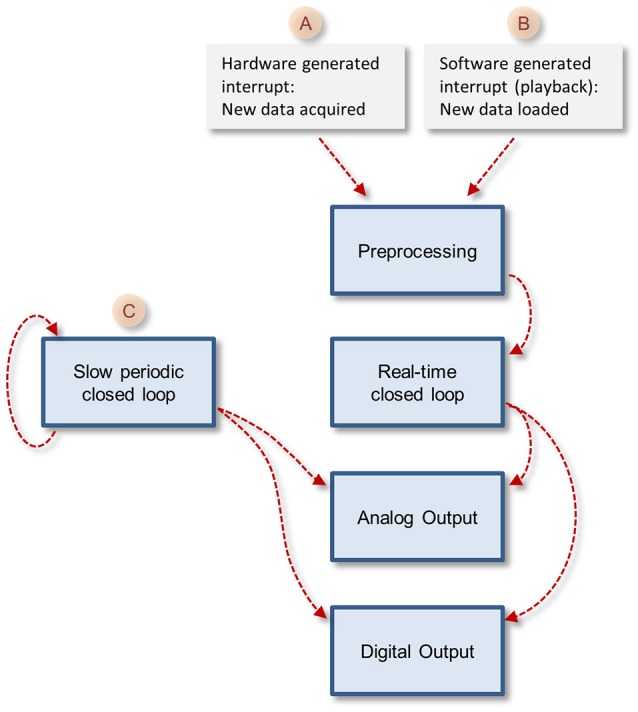
The closed loop pipelines. Note that the execution of each stage is timed by the previous stage in the pipeline, but each of these tasks runs in its own thread. The exception is the slow periodic closed loop pipeline that times itself based on a user-defined time interval.